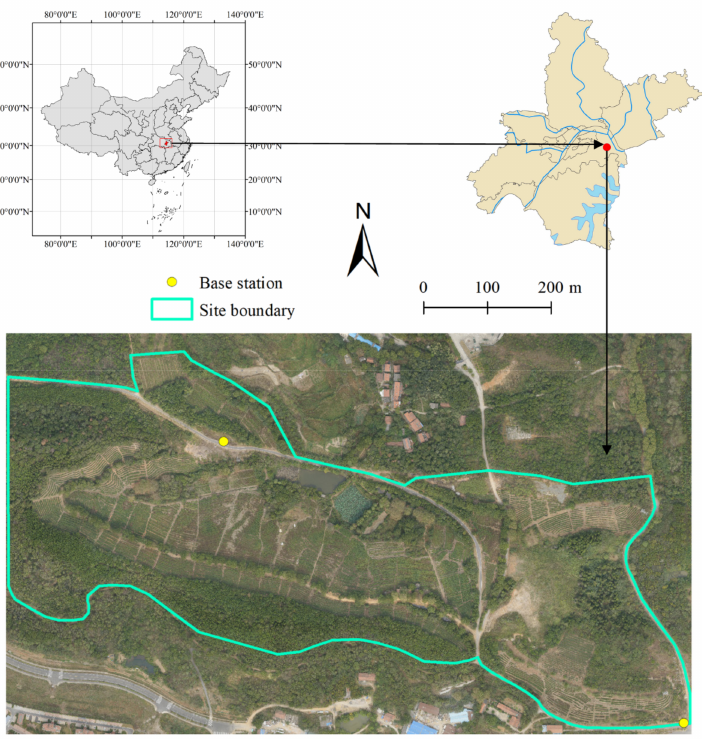
Figure 2. The study area is located in Huashan, Wuhan (digital images, 0.1 m